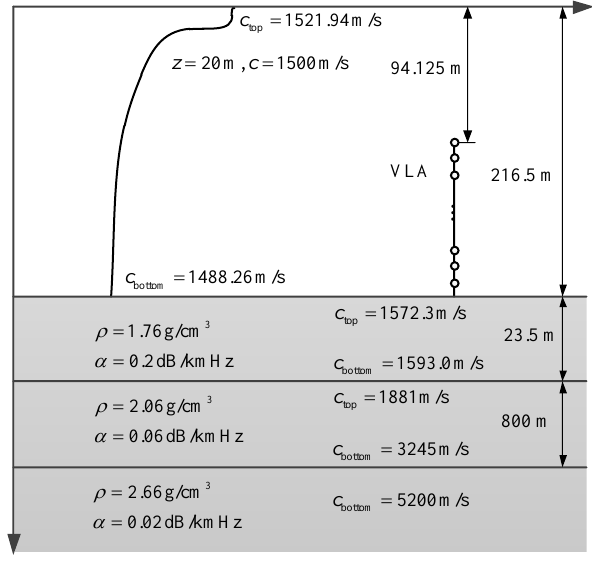
Figure 7. Environmental parameters of the waveguide and configuration of the VLA.